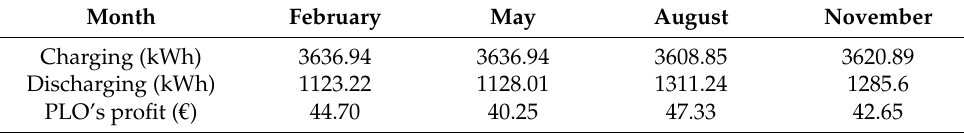
Table 5. Charging/discharging energy of EVs and PLO’s profit.